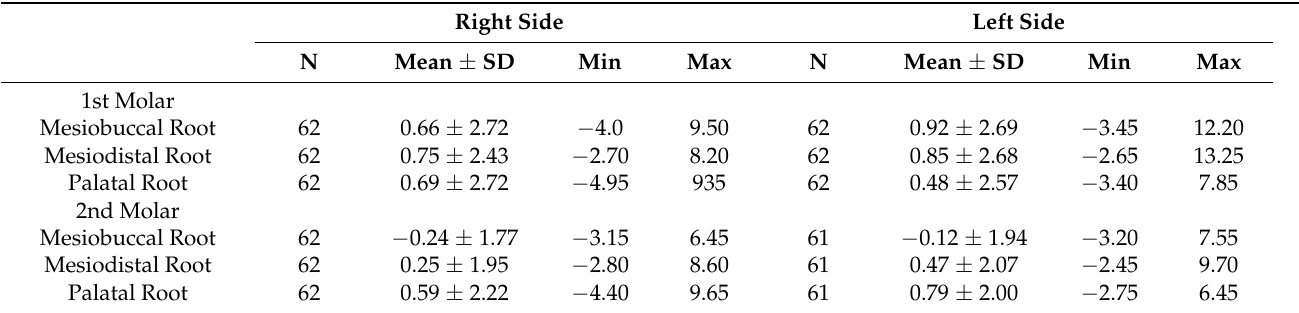
Table 2. Mean root–maxillary sinus distances in mm for 1st and 2nd molars. Right Side